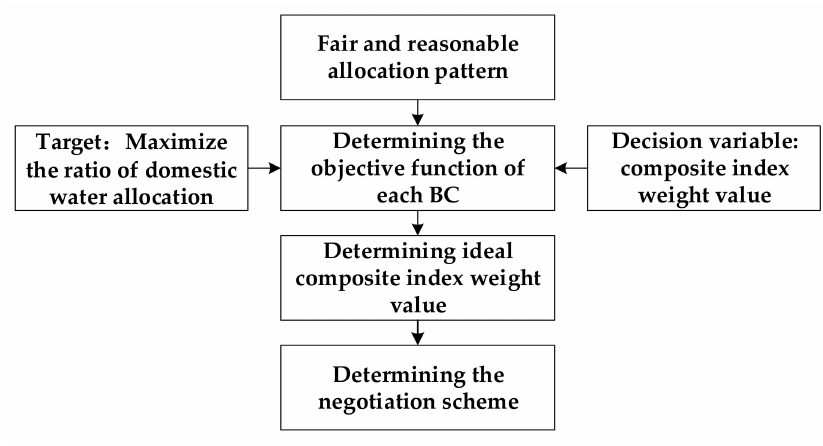
Figure 3. The process of determining the negotiation scheme of each